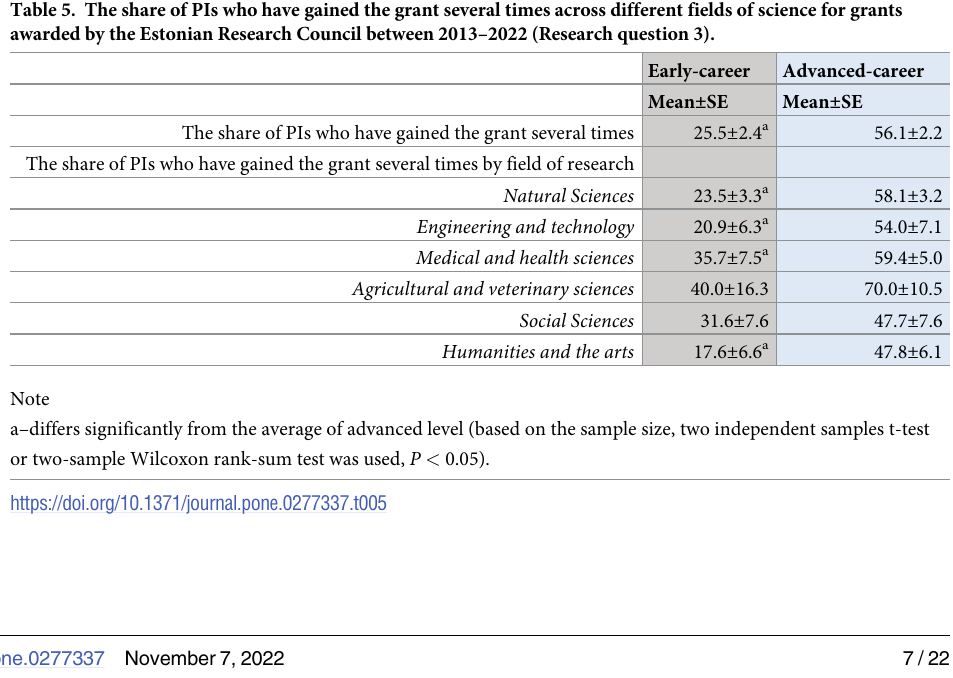
Average normalized number of articles ( N n , yr -1 )